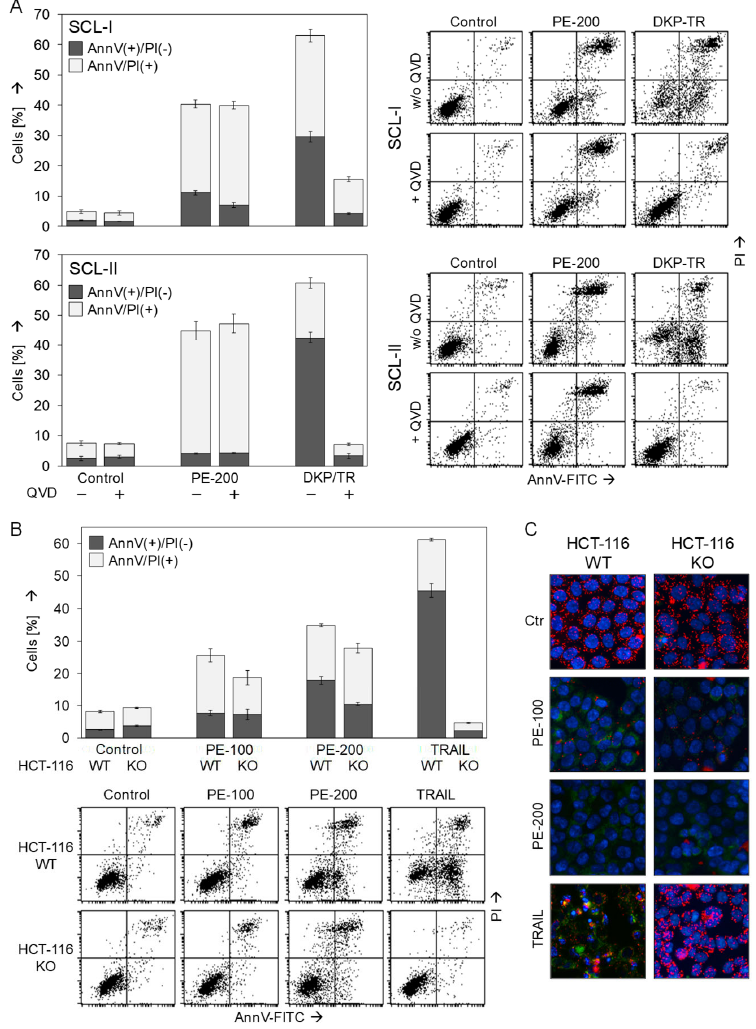
Figure 5. Less effects of caspase inhibition and Bax/Bak knockdown. ( A ) SCL-I and SCL-II cells were treated with 200 µ g/mL PE (PE-200) or with an indirubin derivative DKP-071 in combination with TRAIL (DKP/TR, positive control). In addition, cells received the pancaspase inhibitor Q-VD- Oph (10 µ M), when indicated. ( B , C ) HCT-116 WT cells and HCT-116 double knockout cells for Bax and Bak (KO) were treated with PE (100 or 200 µ g/mL) or with TRAIL (positive control). ( A , B ) Cell death analysis by AnnV/PI staining and flow cytometry was performed after 24 h. Representative flow cytometry histograms of treated and control cells are shown on the right side or below. Mean values and SDs of two cell death fractions, namely AnnV(+)/PI( − ) and AnnV(+)/PI(+) cells are shown (in %). ( C ) For microscopic visualization of low MMP and of morphological changes, cells were double stained with JC-1/Hoechst-33342 at 24 h. Blue, nuclear staining; red, mitochondria with high (normal) MMP; faint green, JC-1-stained cytosol; bright green or turquoise, rounded and detached